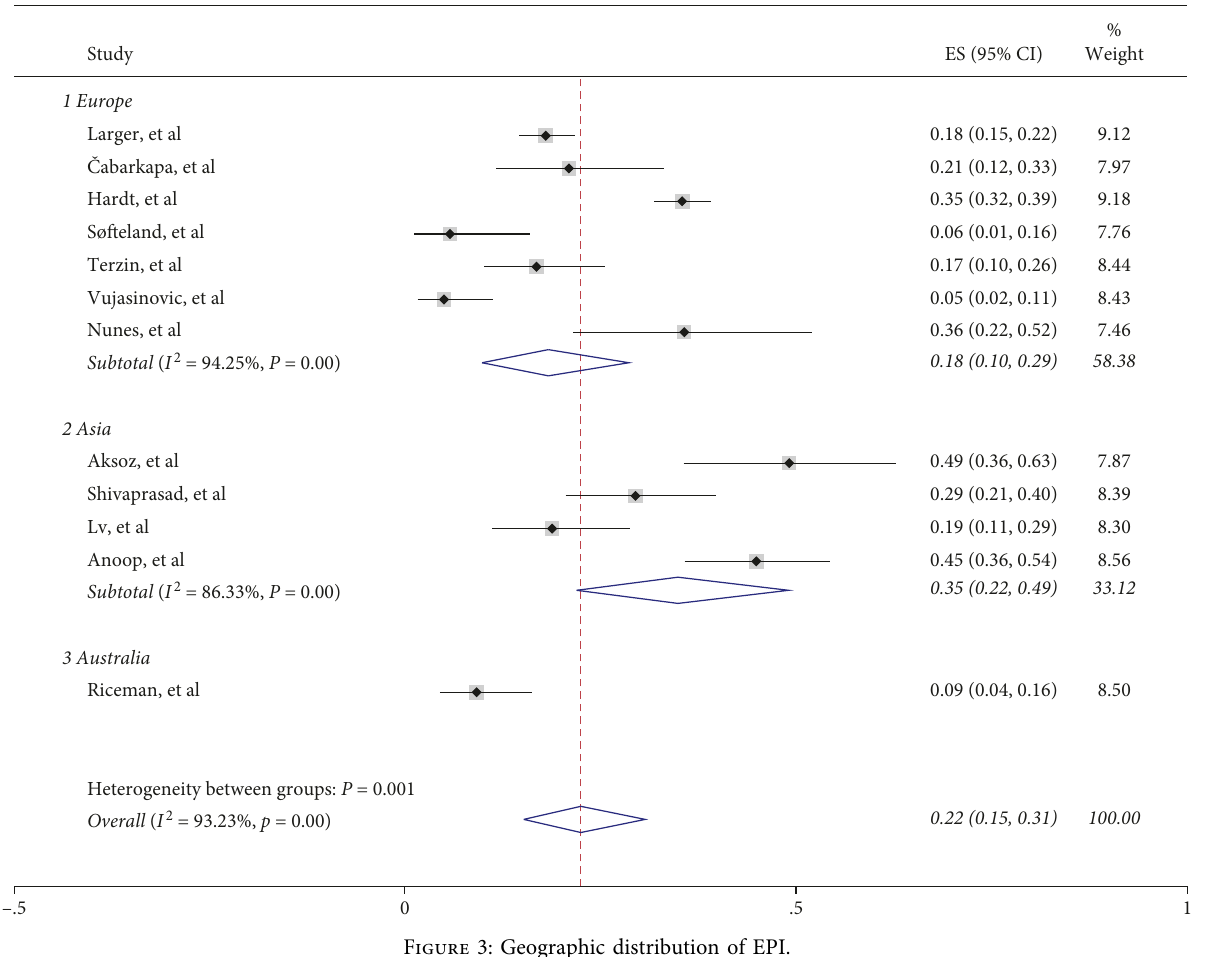
Figure 3: Geographic distribution of